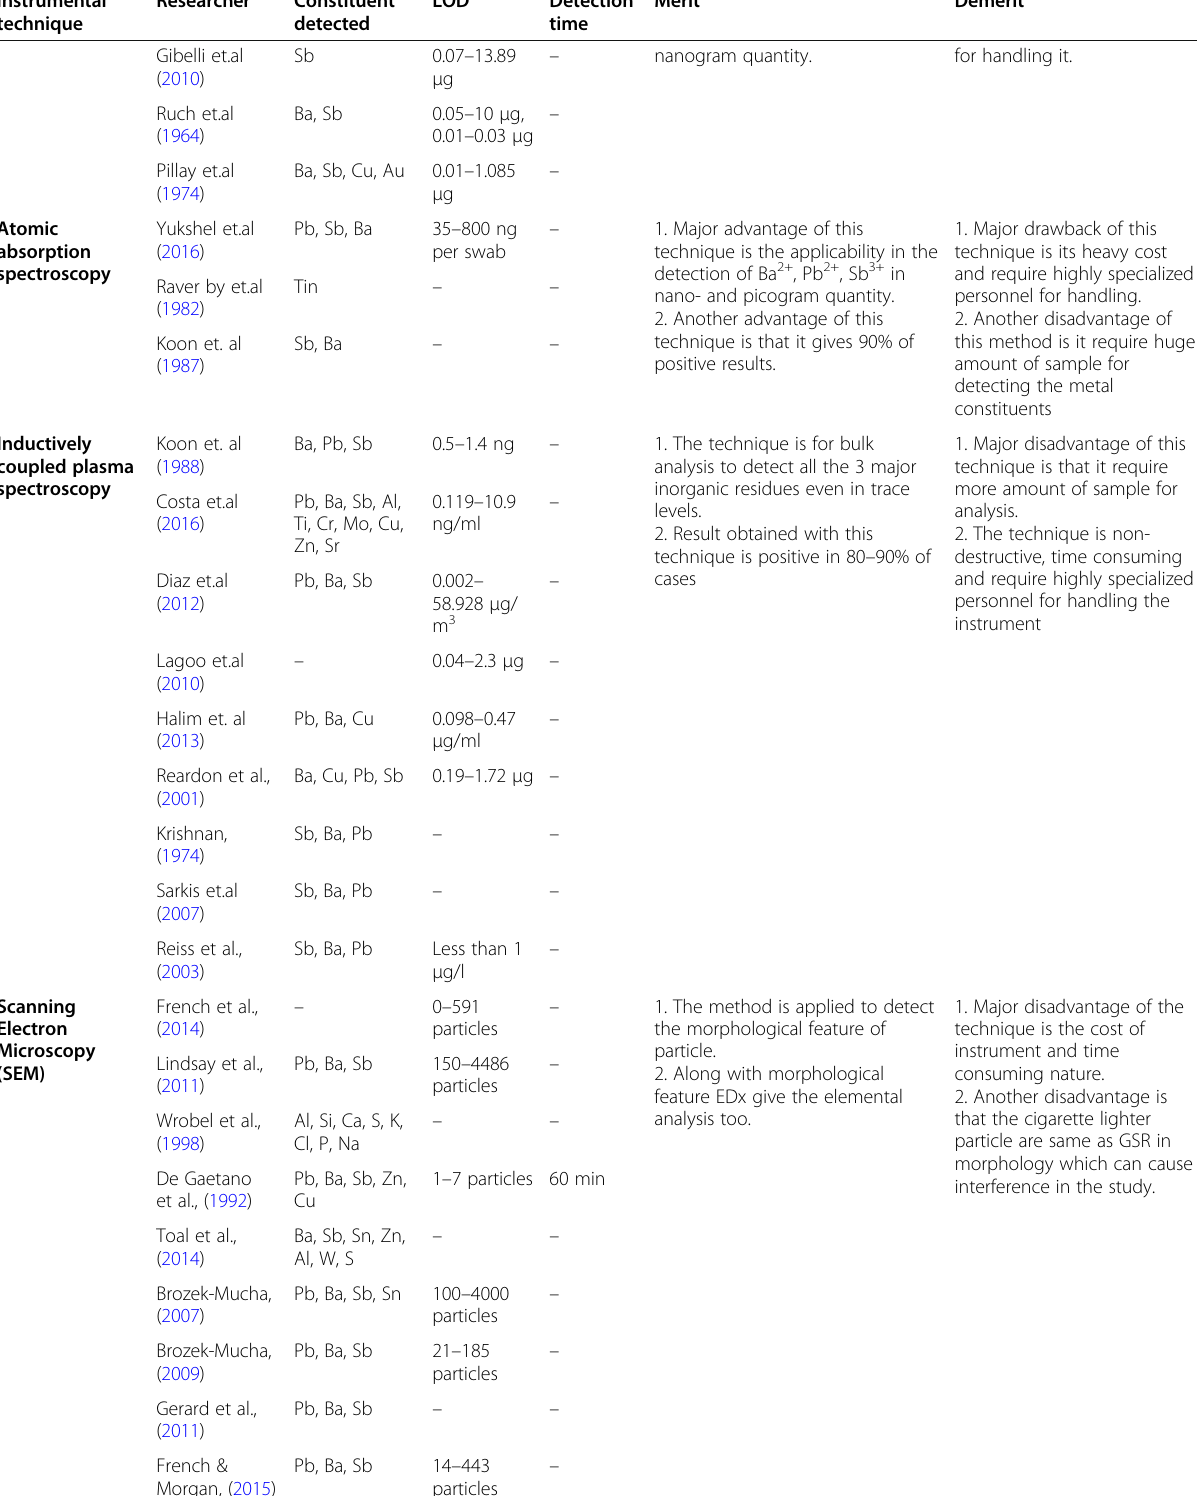
Table 4 Combined analysis of organic and inorganic gunshot residues using instrumentation technique (Continued) Instrumental